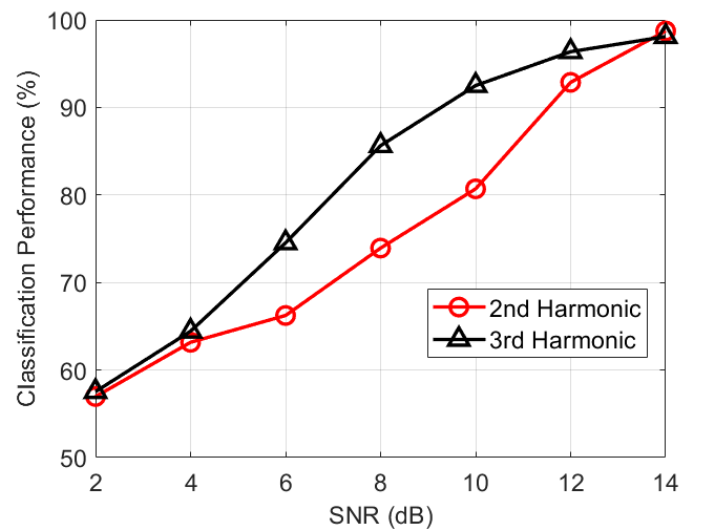
Table 2. Confusion matrices for each harmonic in 3D statistical space for SNR=8 dB.